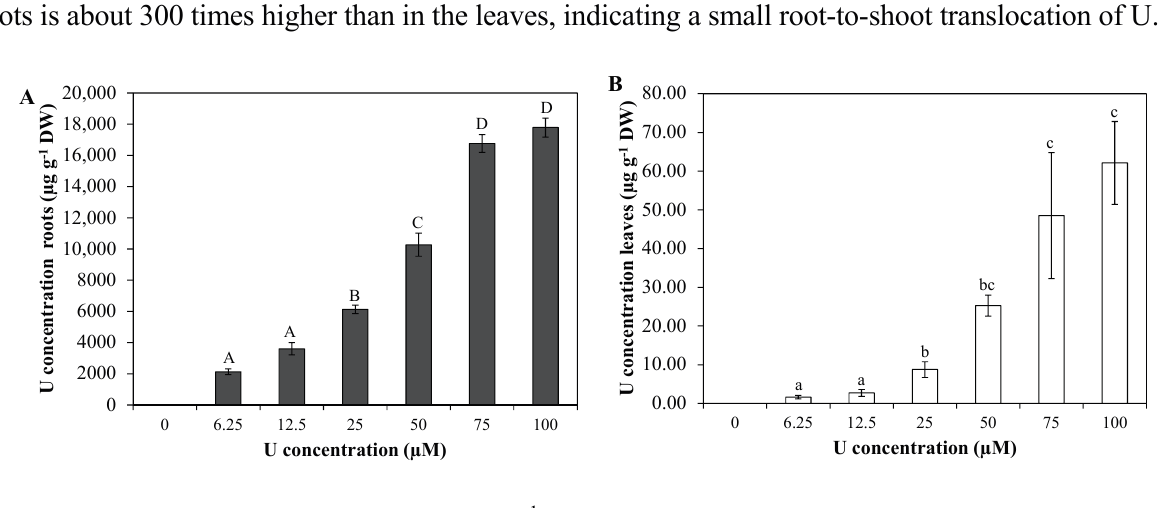
Figure 1. Uranium concentration (µg·g − 1 DW) in Arabidopsis thaliana roots ( A ) and leaves ( B ) exposed to different U concentrations for three days at pH 7.5. Statistical analyses were done separately for leaves and roots. Each point represents the mean ± standard error (S.E.) of at least four biological replicates. Data points with different letters are significantly different ( p <